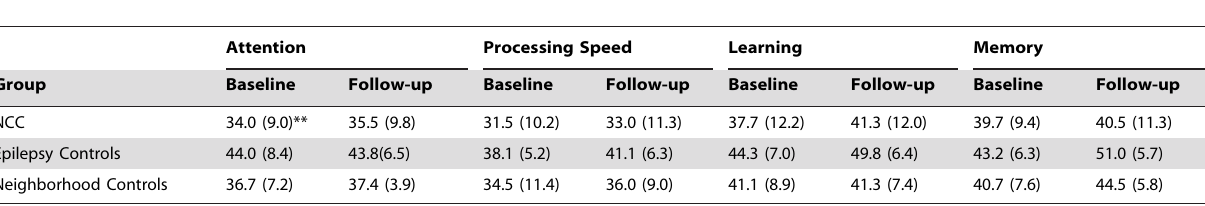
Table 3. Composite age and education-adjusted test scores for major cognitive domains at baseline and 6-month follow-up.